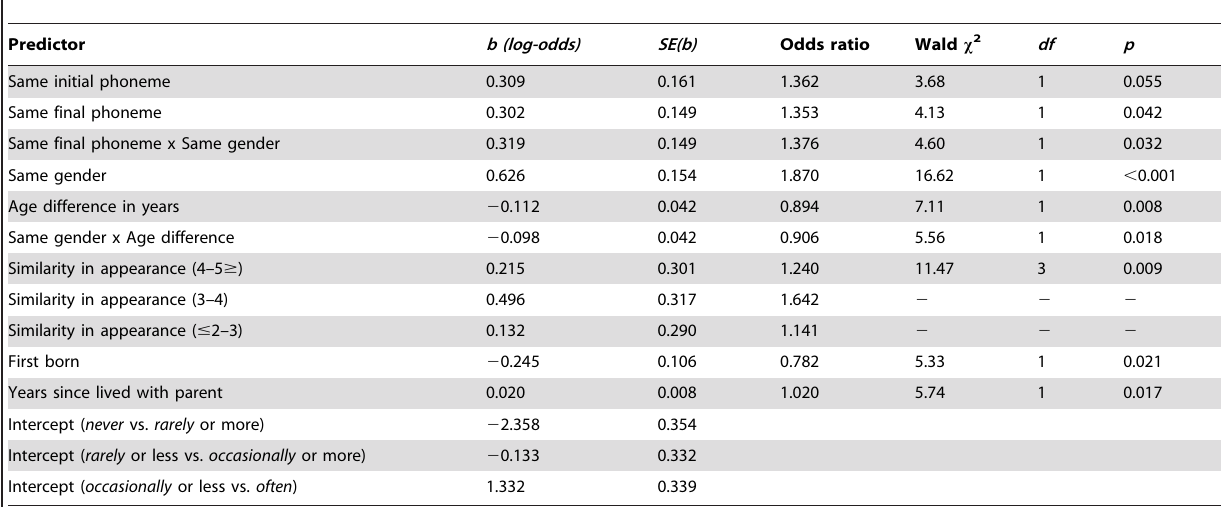
Table 1. Parameters for the best fitting cumulative odds ordinal regression model for lifetime frequency of sibling name substitutions by a parent.